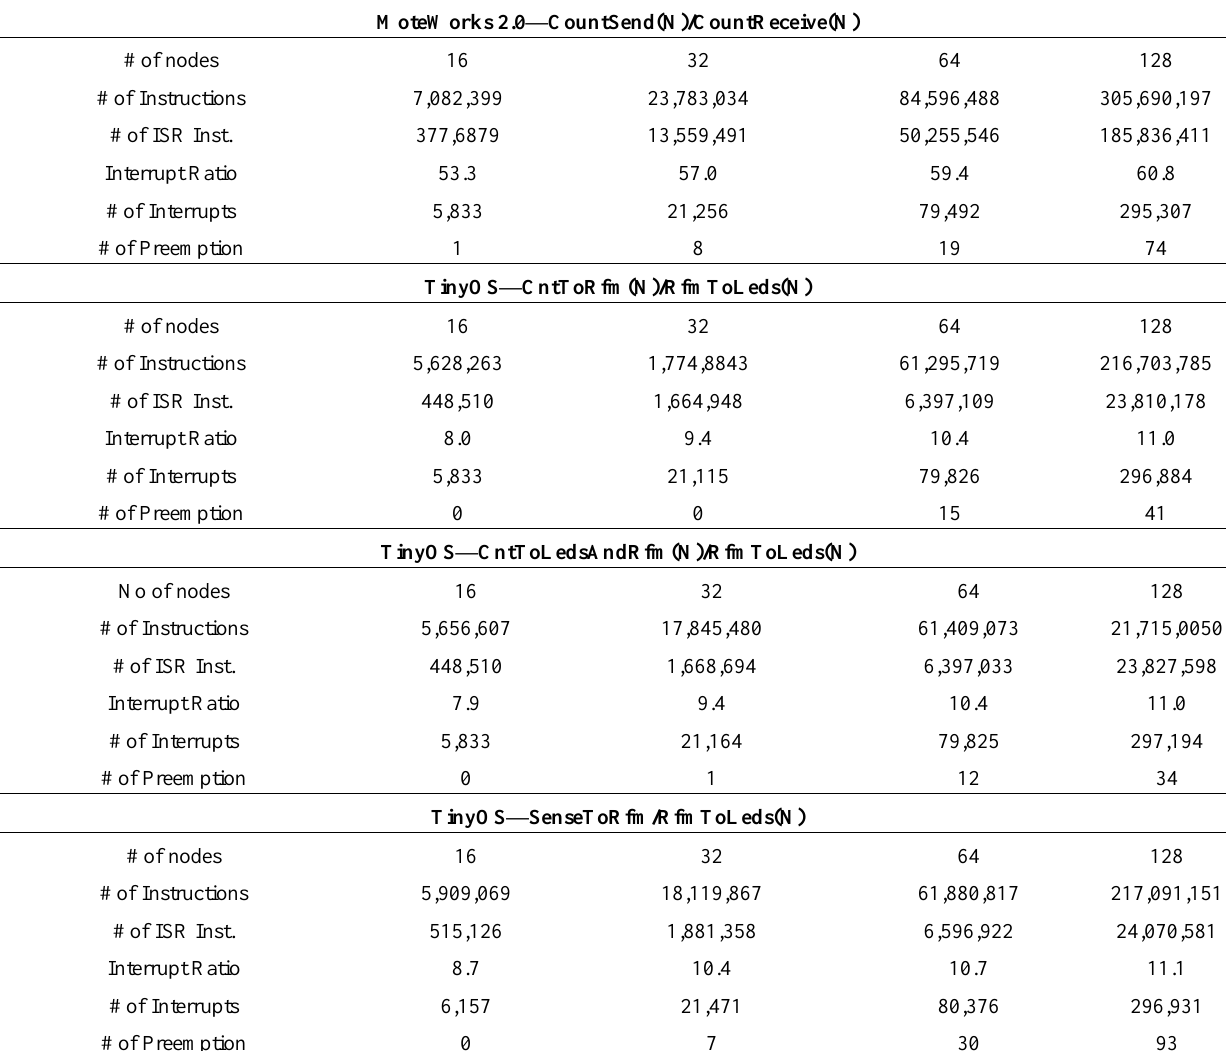
Table 4. Profiling results of sensor network applications for ISR (N senders, N